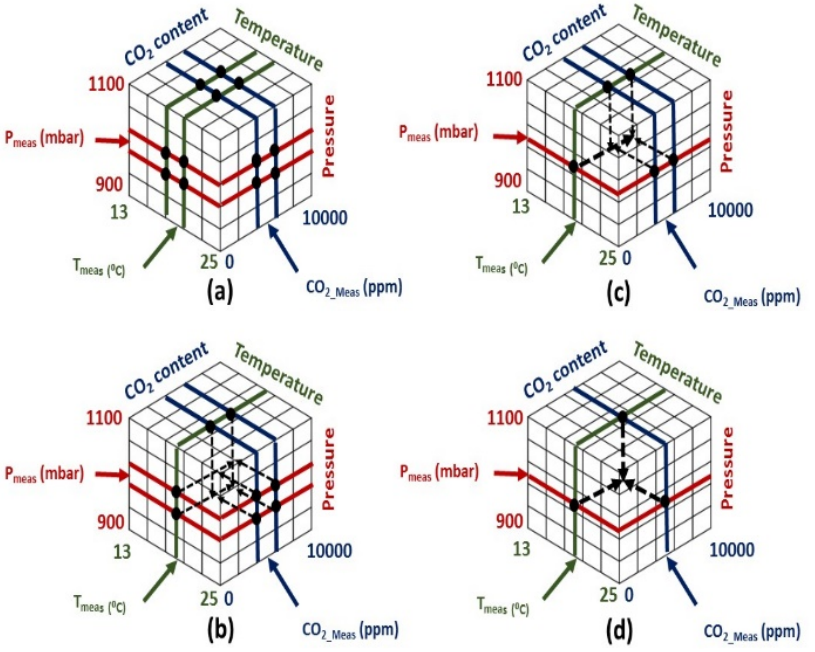
Figure 8. Schematic showing the three-step successive interpolation of sound velocity vs. {C 3 F 8 in N 2 } concentration fit parameters held in ‘cans’ (•) at the nearest stored grid intersections to deter- mine those corresponding to the measured {T, P, CO 2 contamination} process conditions. See text for explanation of interpolation steps ( a – d